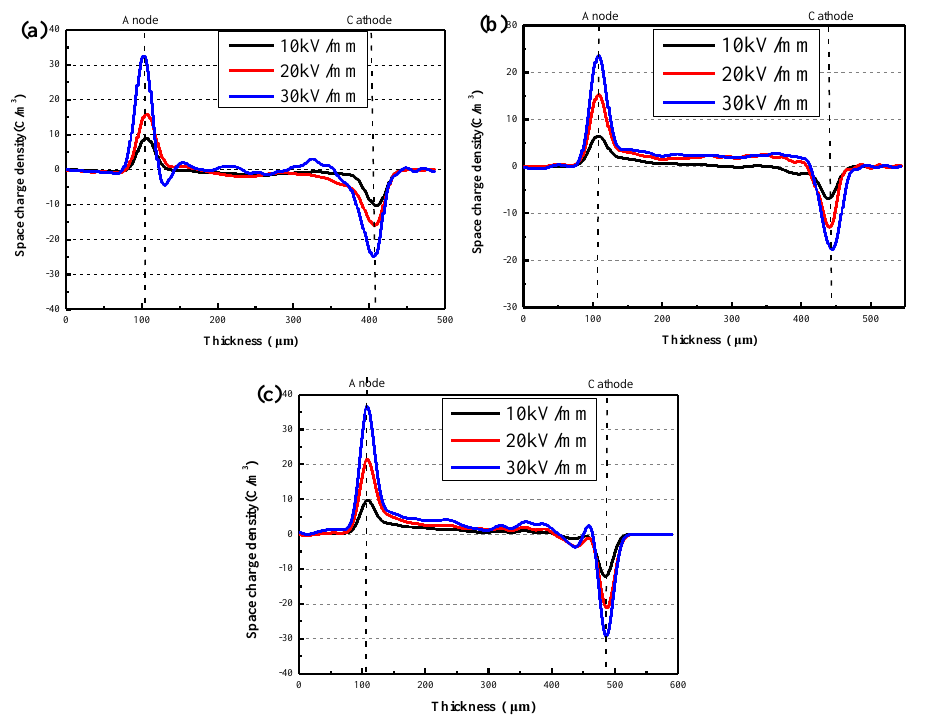
Figure 13. ( a ) The space charge density of pure XLPE varies with field intensity. ( b , c ) The space charge density of the XLPE / α -Al 2 O 3 nanocomposites containing 0.2 wt % and 0.5 wt % of α -Al 2 O 3 varies with field intensity.